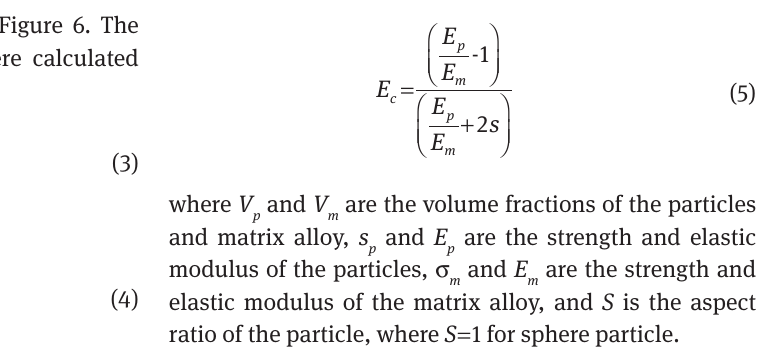
-filled A384 alloy composites. (B) Von-mises stress in 2 wt.- % micro-TiO 2 -filled A384 alloy composites. (D) Von-mises stress in 6 wt.- % micro-TiO 2 -filled A384 alloy composites (For Flexural strength). 2